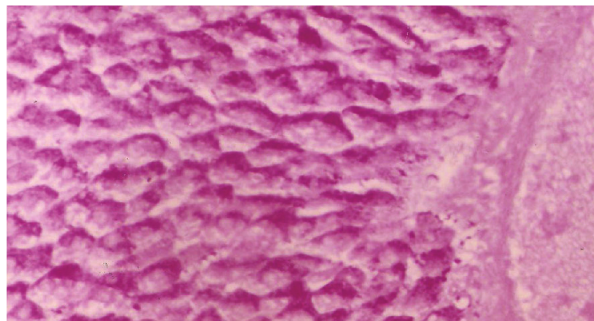
Figure 7: Photomicrograph of liver section of normal rat offspring after birth showing a moderate amount of carbohydrate granules ( ×